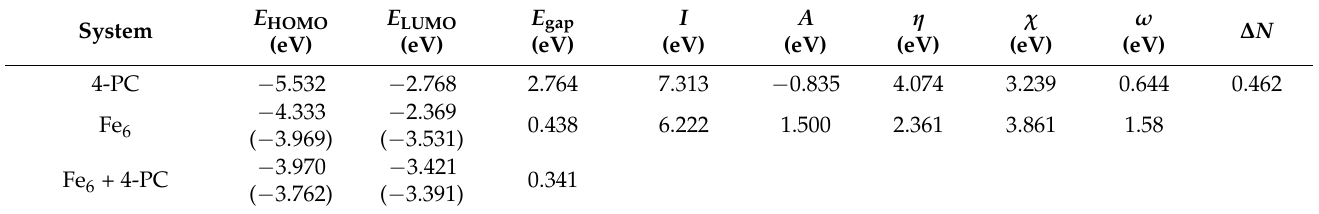
Table 3. Energetic and global parameters calculated for 4-PC, Fe 6 cluster, and their compounds. Values between parentheses are related to beta, spin down,